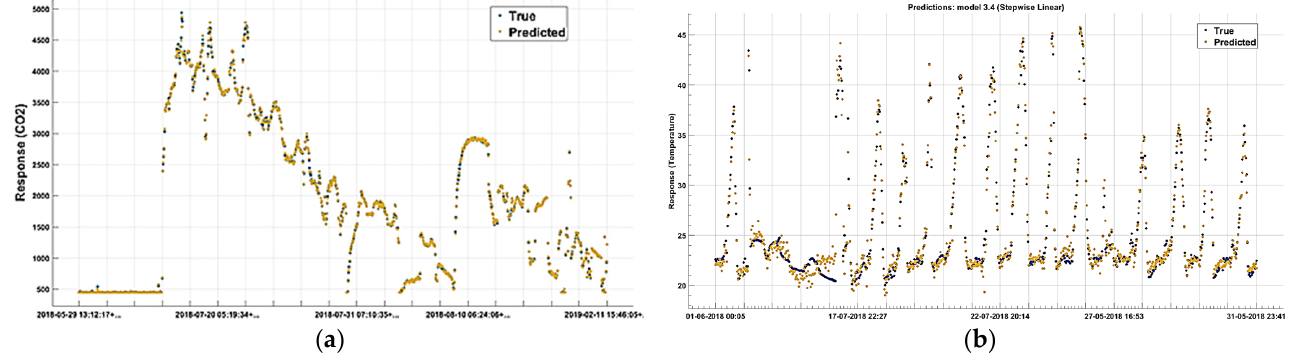
Figure 9. The Bi-cluster formation from QU-H10 and QU-C05 data captured during 8 h from CO2 and Temperature Variables. ( a ) The OBRM1 Response for CO2 (ppm) and ( b ) The OBRM2 Response for Temperature (°C).